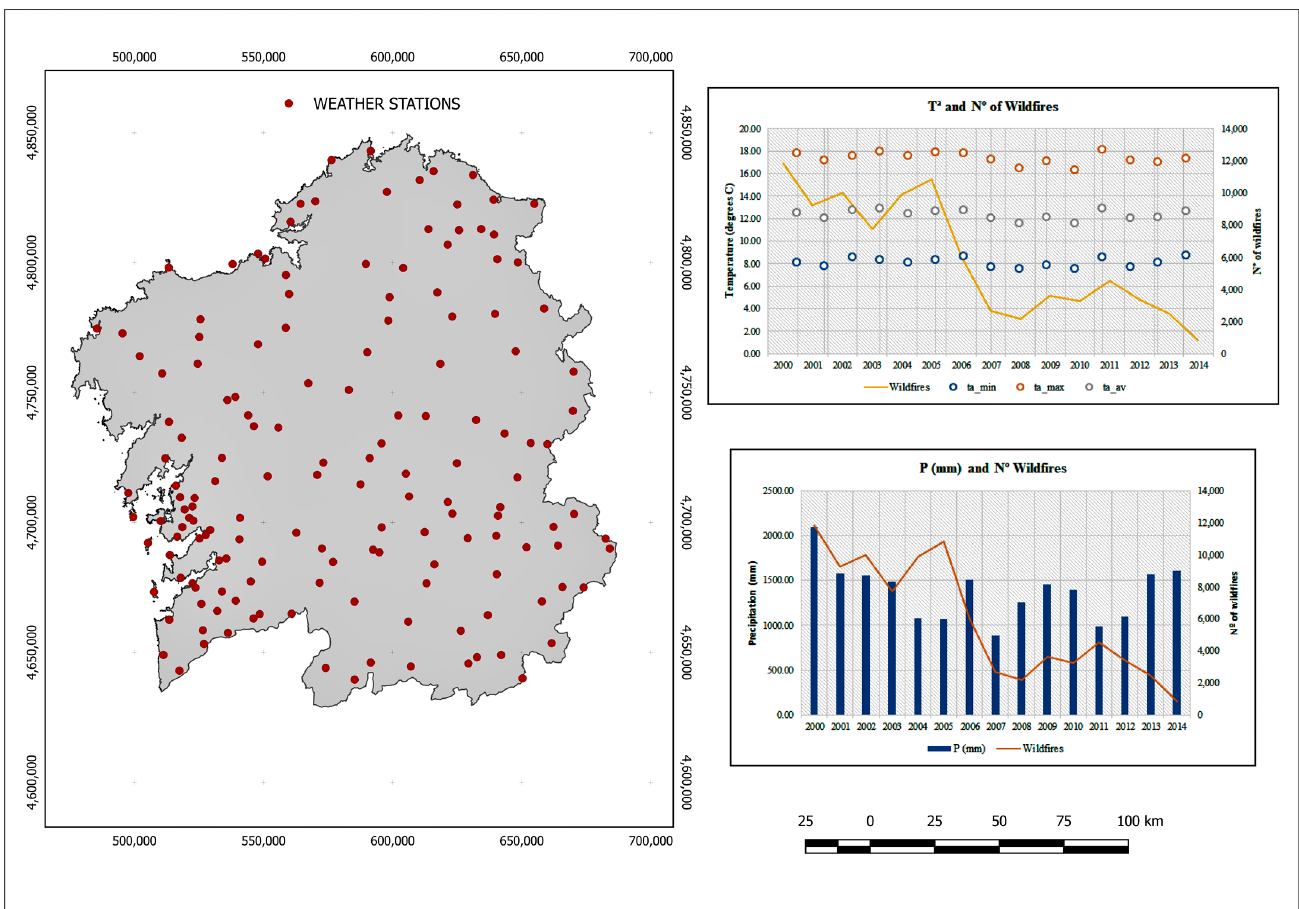
Figure 3. The distribution of the climatological stations used in the study and the historical evolution of temperature and precipitation during the study period. The temperatures used were mean minimum temperature (ta_min), mean maximum temperature (ta_max) and mean temperature (ta_av). The annual precipitation (P) was measured in mm. The historical evolution of the number of human-induced fires was superimposed on the climate